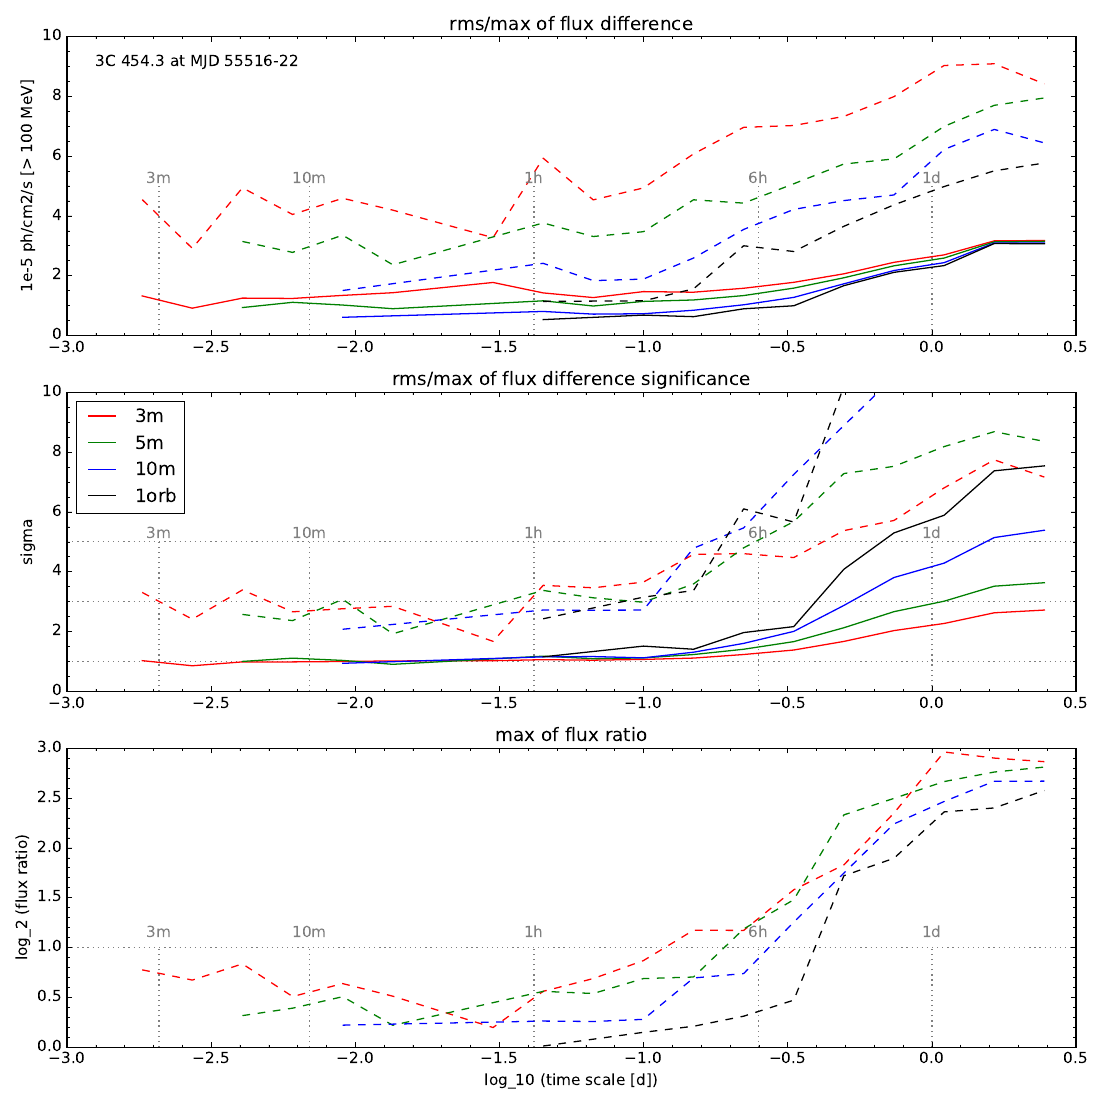
Figure 4. Variability statistics as functions of observed time scale for the gamma-ray flux of 3C 454.3 during the major flare at MJD 55516-22. Top panel shows the rms ( ∆ f ) (solid lines) and max | ∆ f | (dotted lines) for the distributions of photon flux differences ∆ f = f 2 − f 1 . Middle panel shows the rms ( σ f ) (solid lines) and max | σ f | (dotted lines) for the distributions of photon flux difference significances σ f = ∆ f / δ f . Bottom panel shows the max ( R f ) (dotted lines) for the distributions of photon flux ratios R f = f 2 / f 1 . The line colours correspond to different characteristic binning time